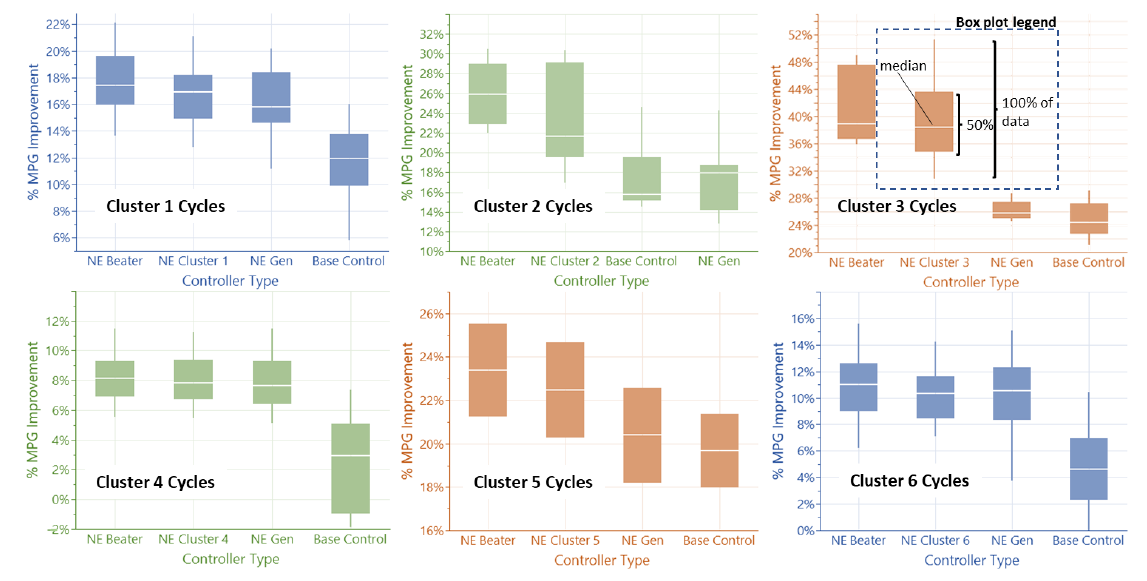
Figure 11. Controller performance comparison for Cluster 1 to 6 showing the improvement of the NE Cluster controller from the General NE controller. The remaining optimal gap is shown versus the NE Beater controller.